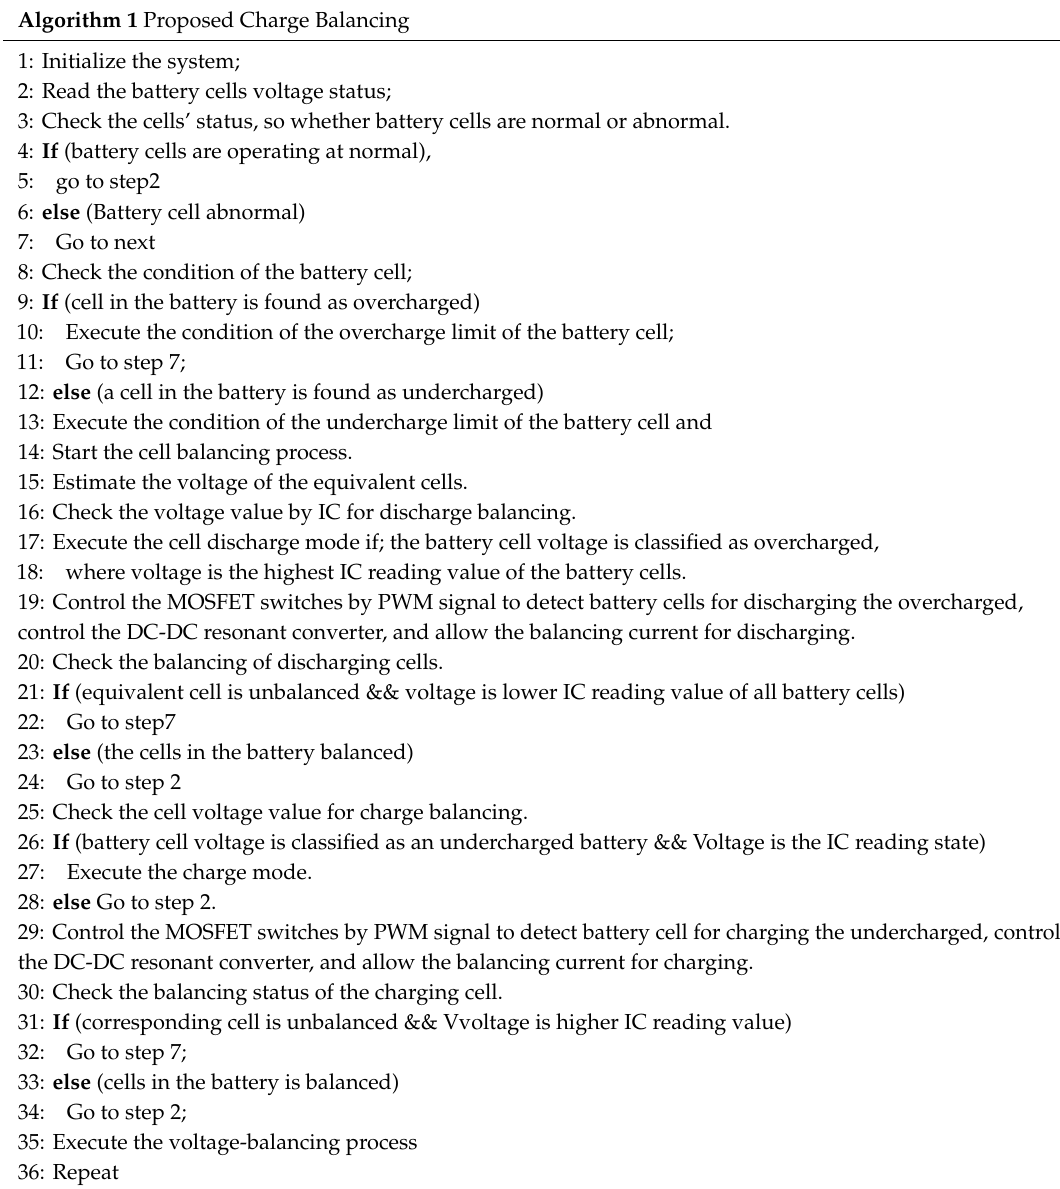
Algorithm 1 Proposed Charge